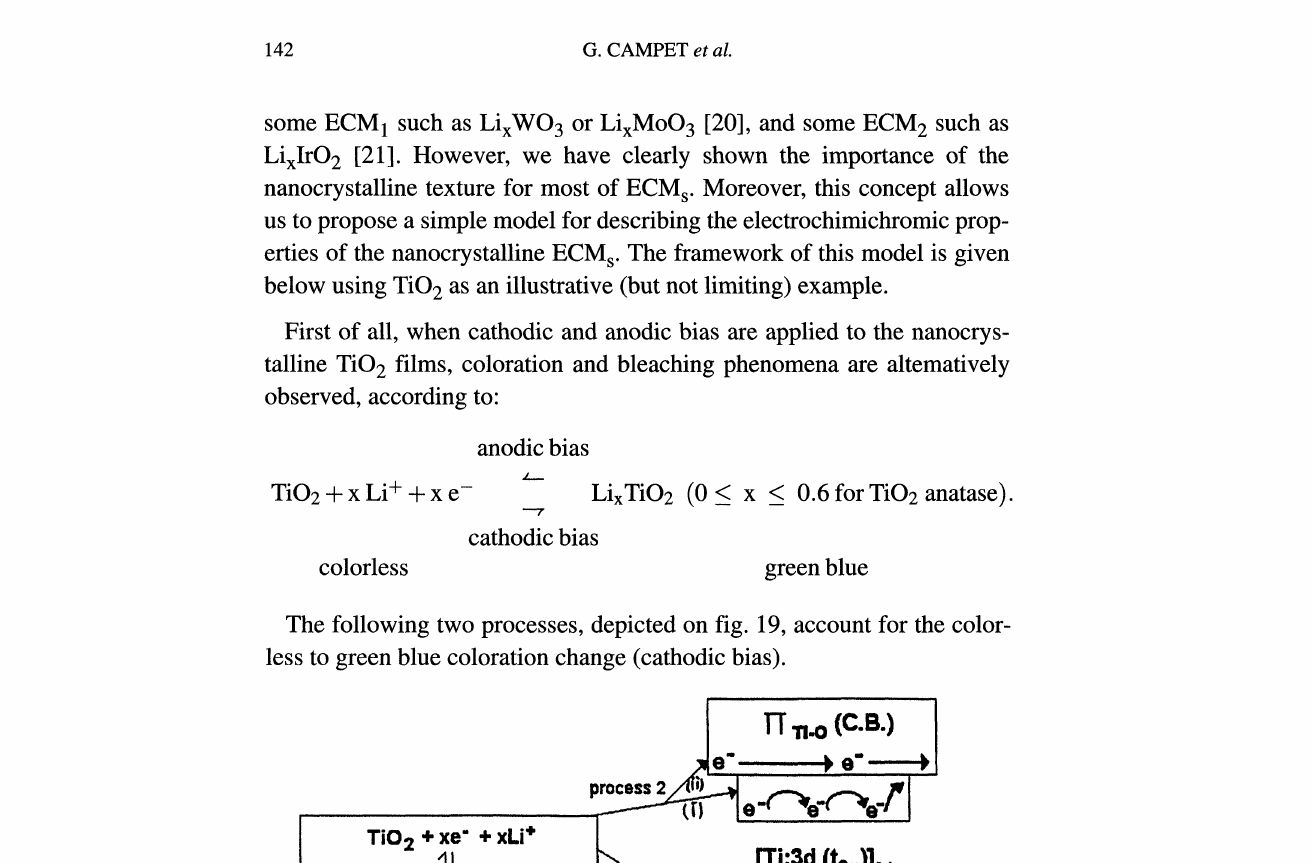
FIGURE 19 Visualization of the electrochemical process accounting for the electronic (electrical and optical) properties of the nanocrystalline TiO 2